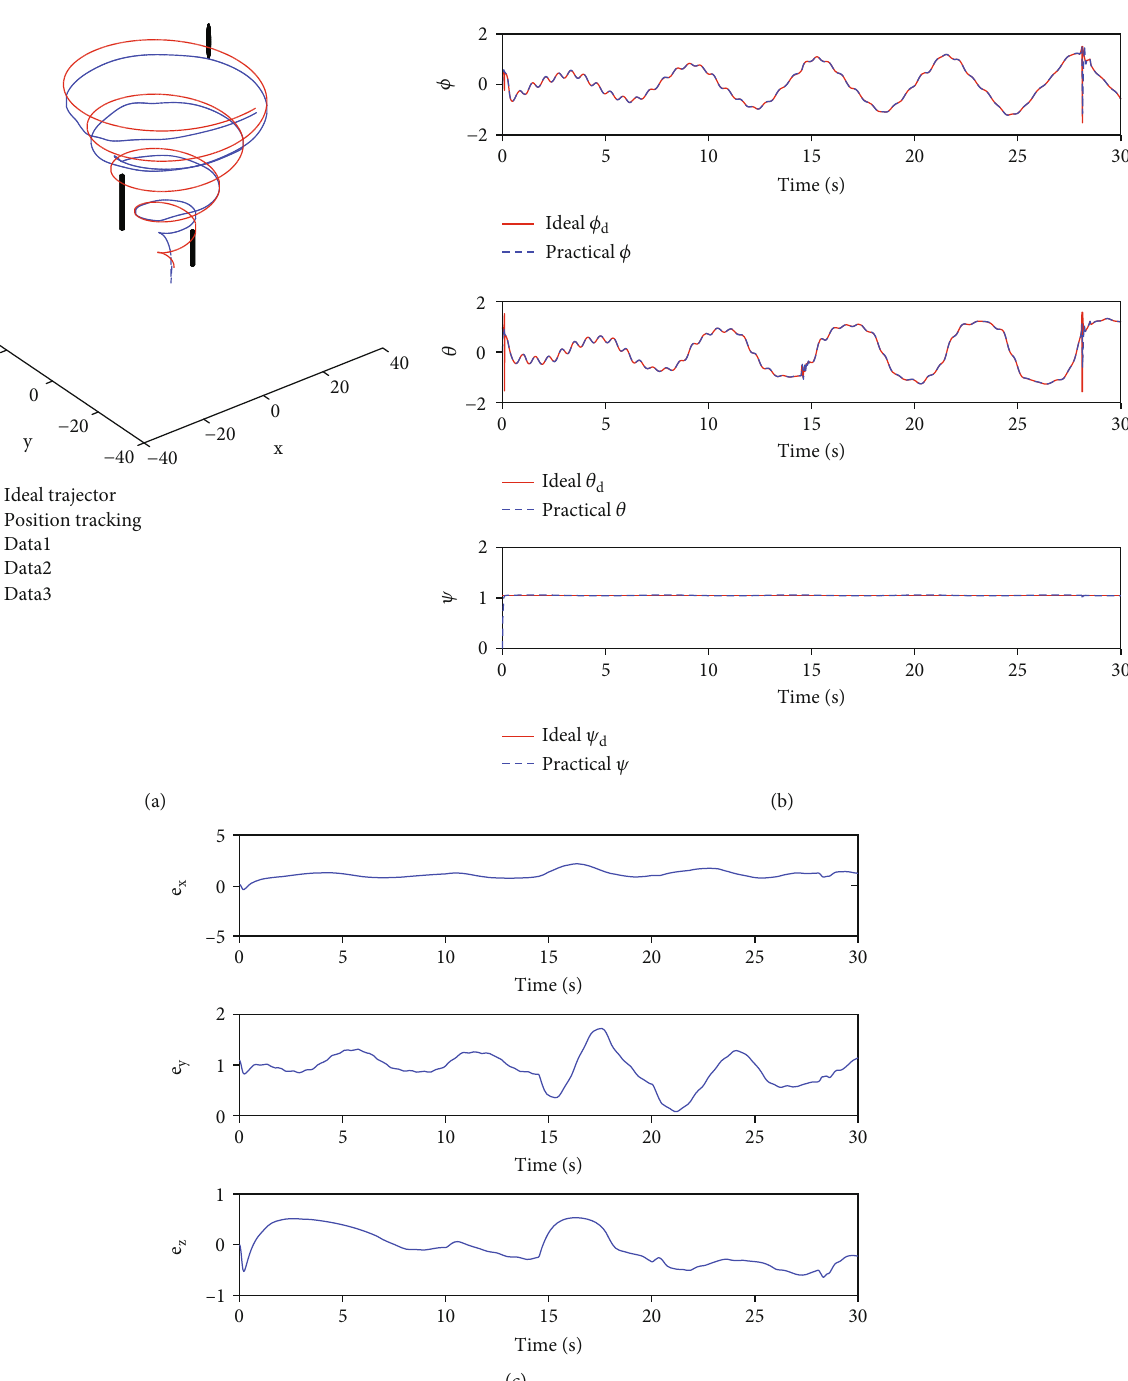
Figure 16: Path tracking in space based on sliding mode control. (a) Trajectory tracking about curve in space. (b) Angle curve about curve in space. (c) Error curve about 3D coordinates in case of path tracking in plane in